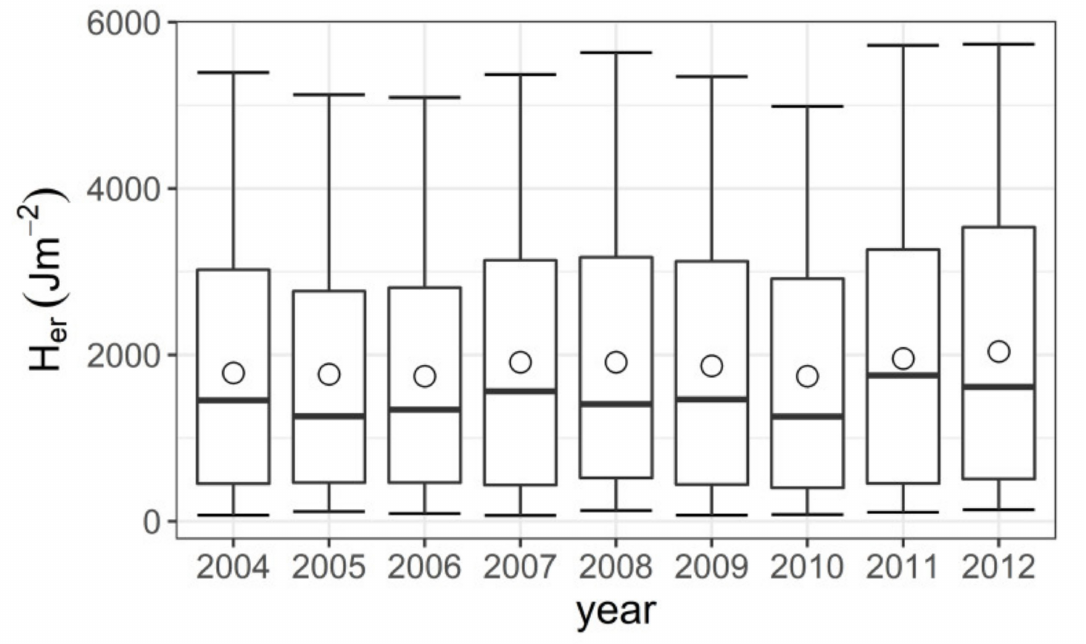
Figure 1. Boxplot of the daily H er in Novi Sad for the period 2003–2012 (the box represents 50% of the central data, with a line inside that represents the median; the edges of the box are the first and the third quartile; the whiskers are minimum and maximum values; the dots represent the